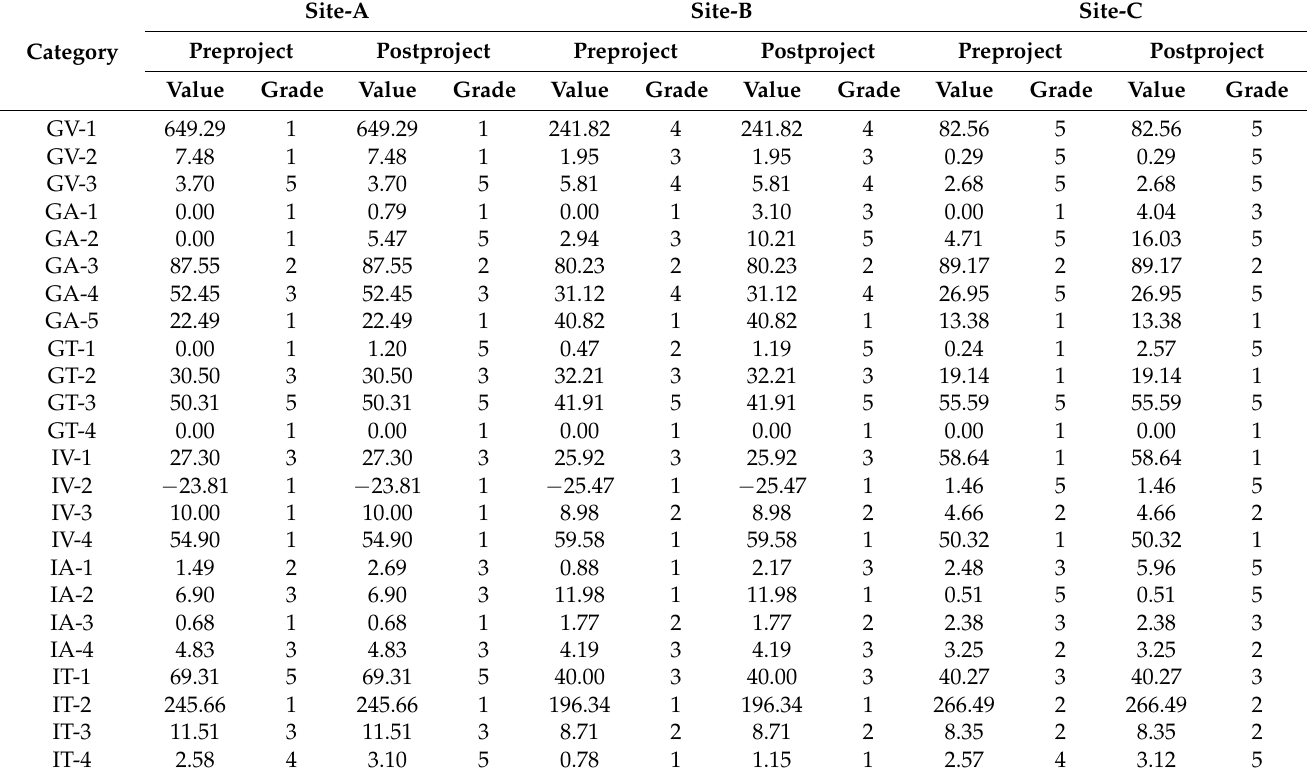
Table 4. The value and grade by target